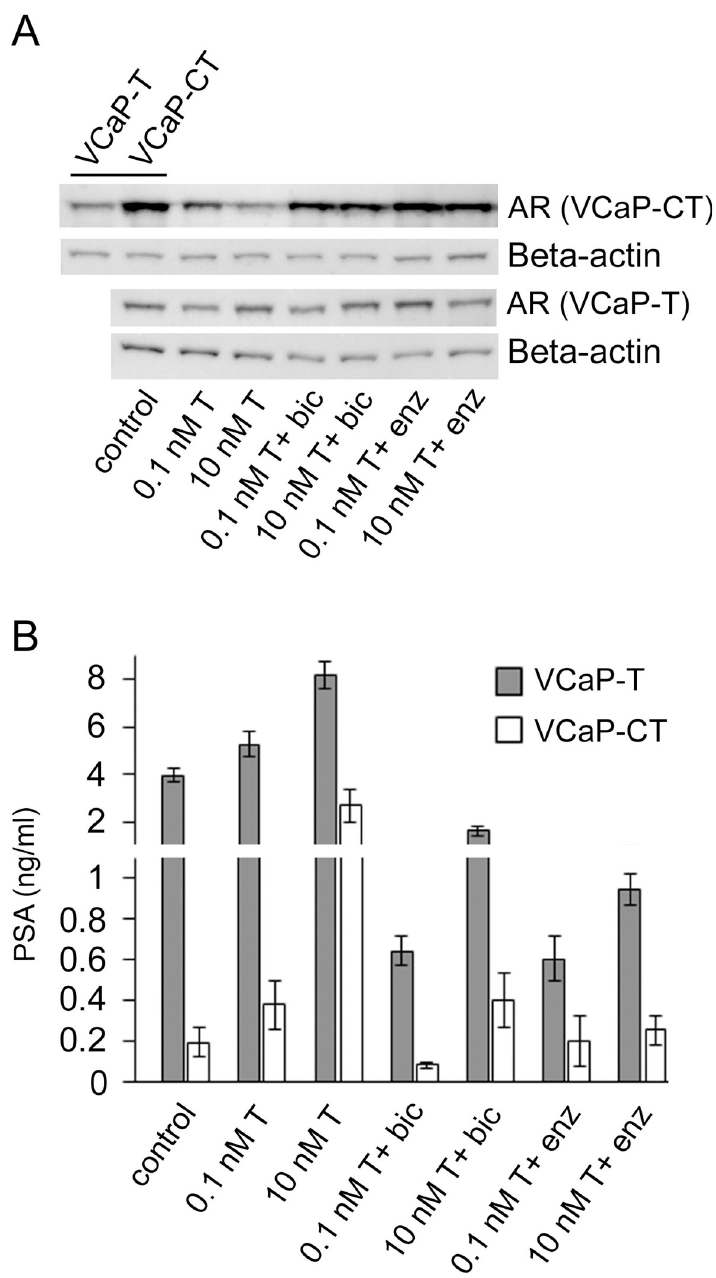
Fig 2. Measurement of androgen receptor (AR) protein and prostate specific antigen (PSA) levels. VCaP-T and VCaP-CT cells were treated with the indicated concentrations of testosterone (T), 10 μ M bicalutamide (bic), 10 μ m enzalutamide (enz) for 72 h, or were hormone-depleted for 72 h (control). (A) Analysis of AR protein levels by Western blotting. Beta-actin was used as a loading control. Control of VCaP-T (top-left corner) was additionally shown in the same Western blot as VCaP-CT to address the difference. Different rows represent different blots. Whole blots with molecular mass markers are presented in S1 Fig. (B) Analysis of the amount of secreted PSA levels. Data are represented as mean ± SD and three separate replicates were